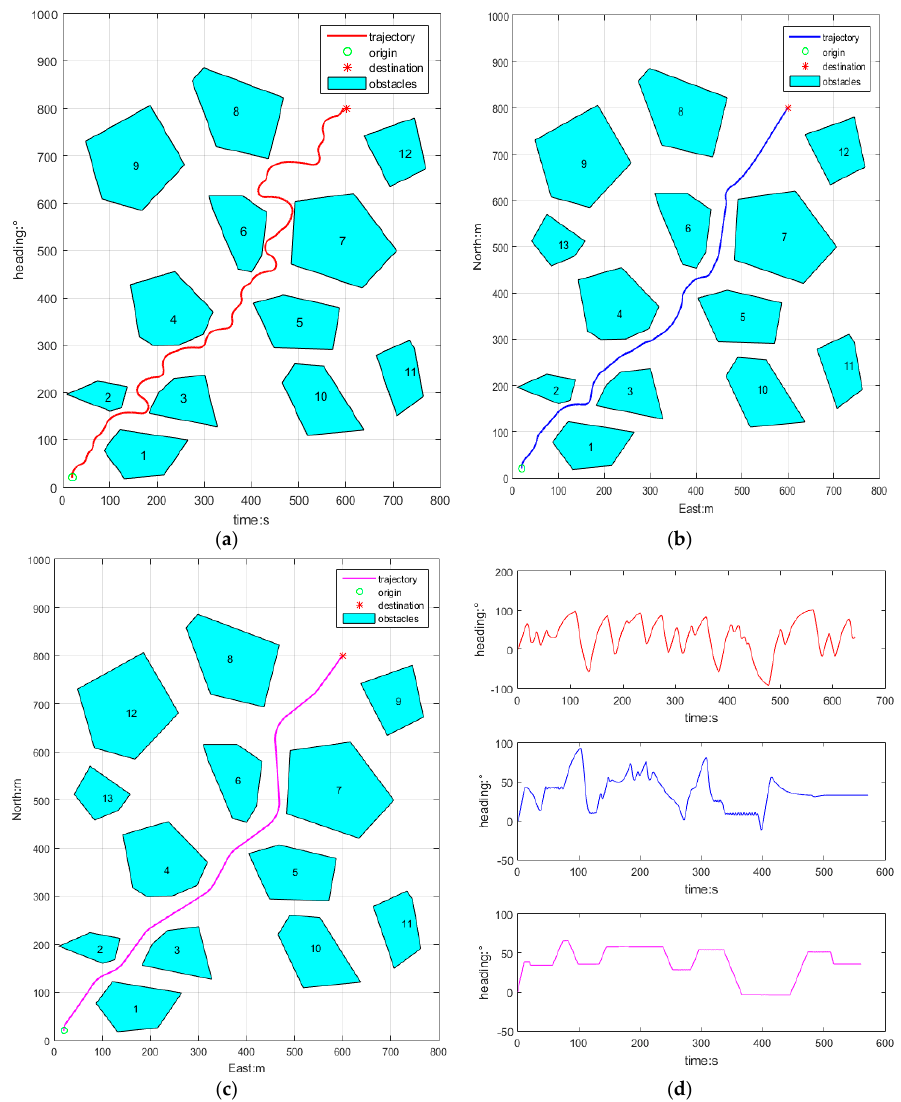
Figure 12. Clutter obstacles environment obstacle avoidance algorithms; ( a ) APF; ( b ) PSO; ( c ) RRA; ( d ) heading curves.